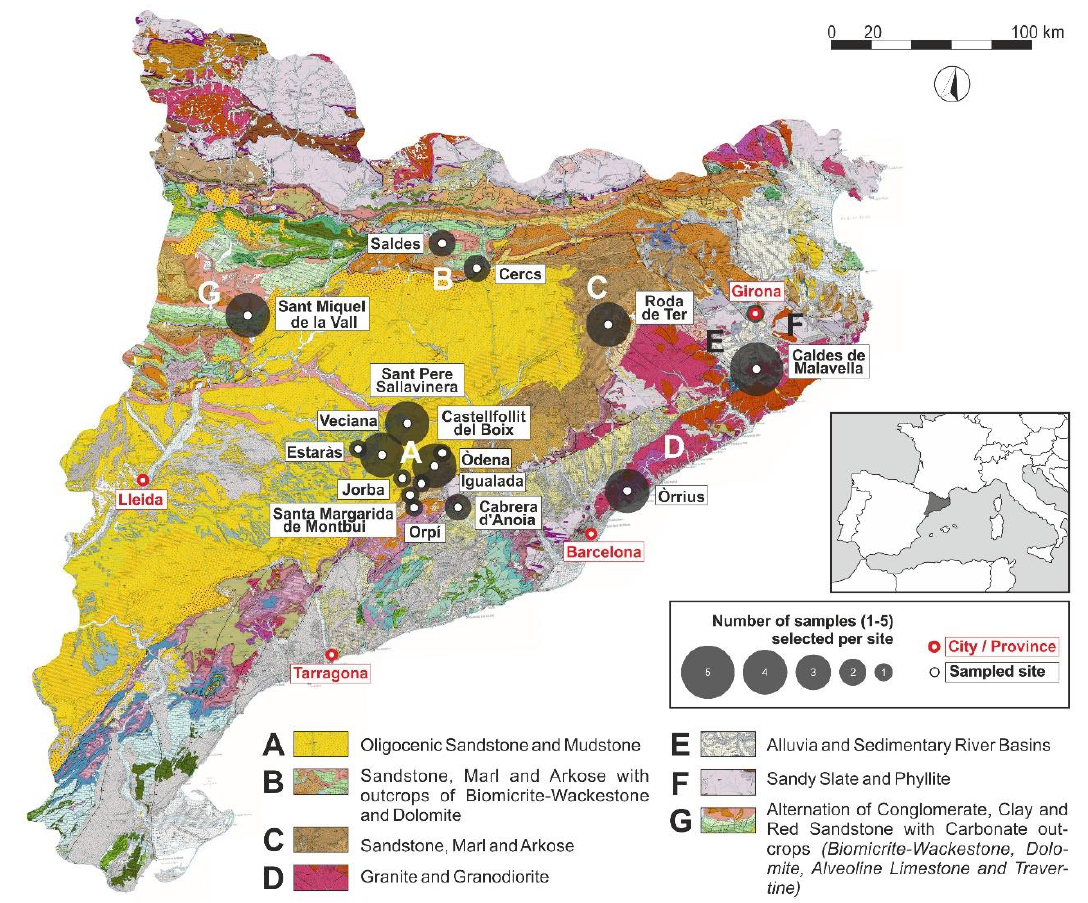
Figure 2. Location map of the samples analysed and the geological environment of the sampled sites. The Geological map of Catalonia is available at the Catalonian Cartographic Institute (ICC: Institut Cartogràfic de Catalunya) website together with its detailed legend [48].